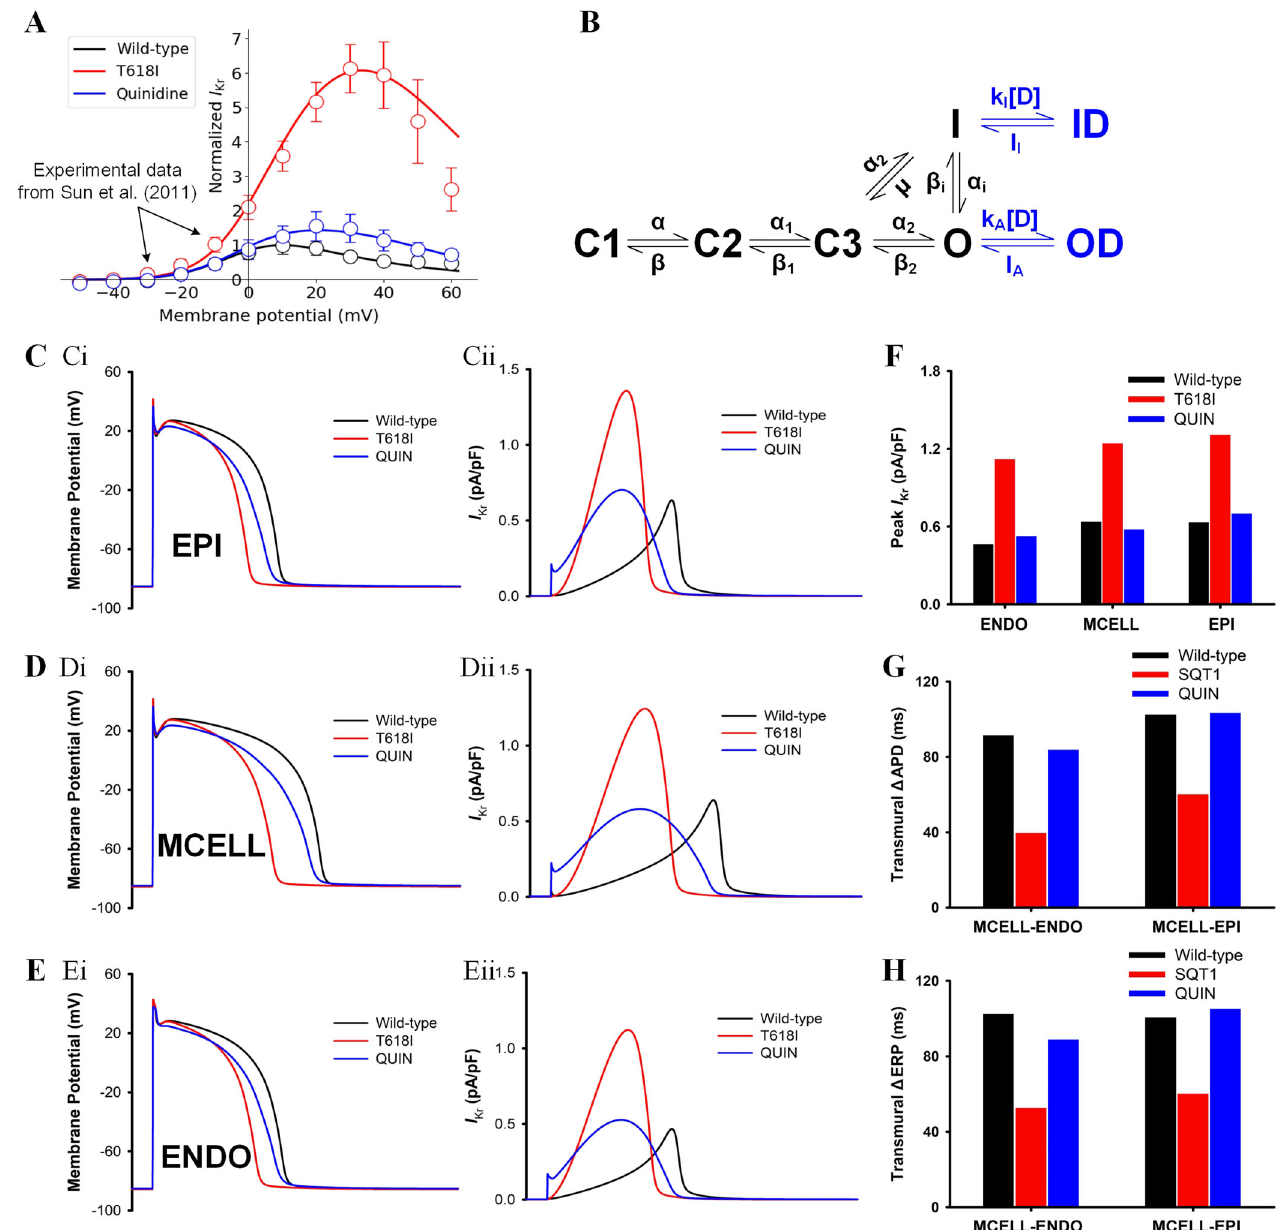
Fig. 7 Actions of quinidine at ion channel and cellular levels. A The fi tted current – voltage (I – V) curves in wild-type (black), T618I (red), and quinidine (blue) conditions using I Kr Markov chain models. Experimental data from Sun et al. 11 (their Fig. 7B). Error bars represent the standard error of measurement (SEM). B The I Kr Markov chain model with two additional drug-related states. C – E Steady-state (1.25 Hz) action potentials and the corresponding I Kr for EPI, MID, and ENDO cells. F The comparison of the peak I Kr . G The comparison of transmural APD differences. H The comparison of transmural ERP